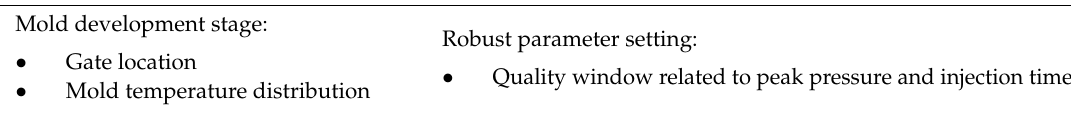
Table 1. Intelligent mold testing technique.